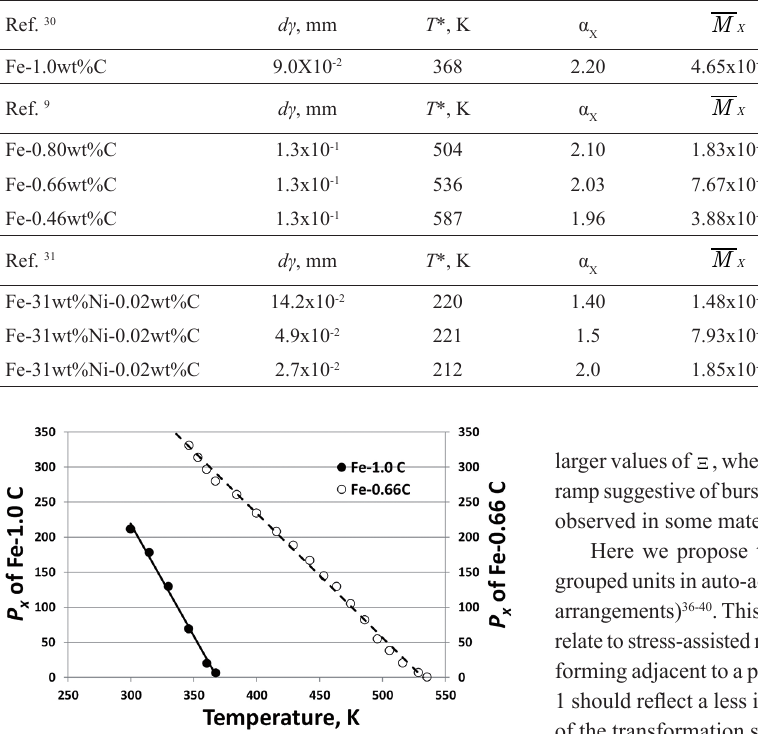
finding austenitic sites to initiate the transformation by two orders of magnitude. The open triangles simulate “athermal” worthy of emphasis that M relates to the initial X